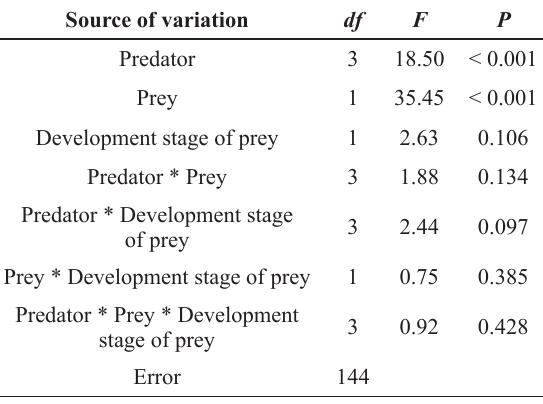
Analysis of variance of the effects of predator species, prey species and development stage on the time of the first attack of Cycloneda sanguinea , Eriopis connexa , Coleomegilla quadrifasciata and Orius insidiosus.